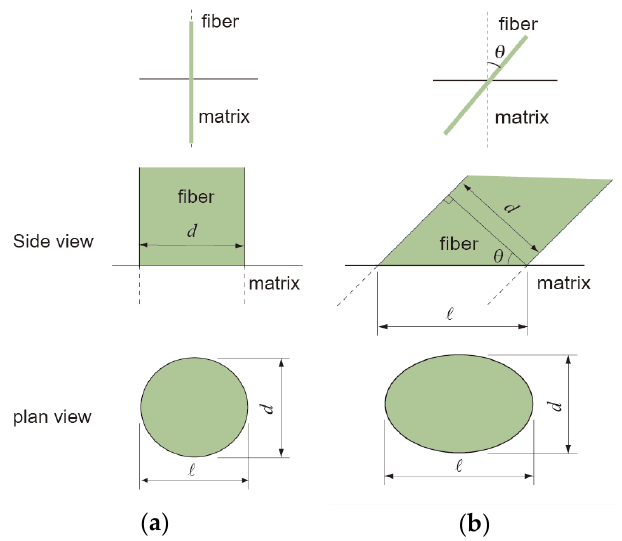
Figure 1. Dimensions of fibers in the side view and plan view on the cutting plane, which is the horizontal line in side view: ( a ) 0 ° orientation and ( b ) θ orientation.